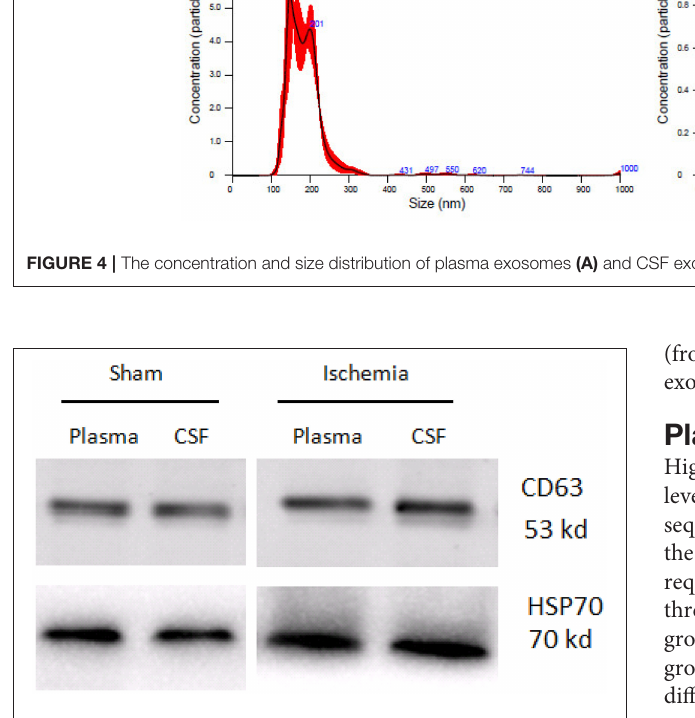
FIGURE 5 | Western blotting analysis of exosome markers, CD63 and HSP70, in the plasma exosomes and CSF exosomes from sham controls and ischaemia